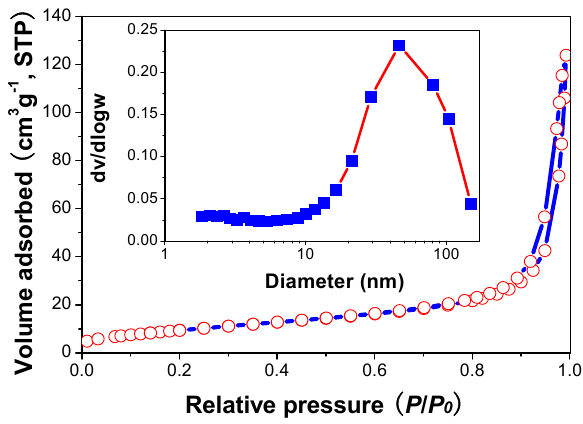
Figure 7. Nitrogen adsorption-desorption isotherm and the corresponding pore size distributions (inset) of R2 sample.